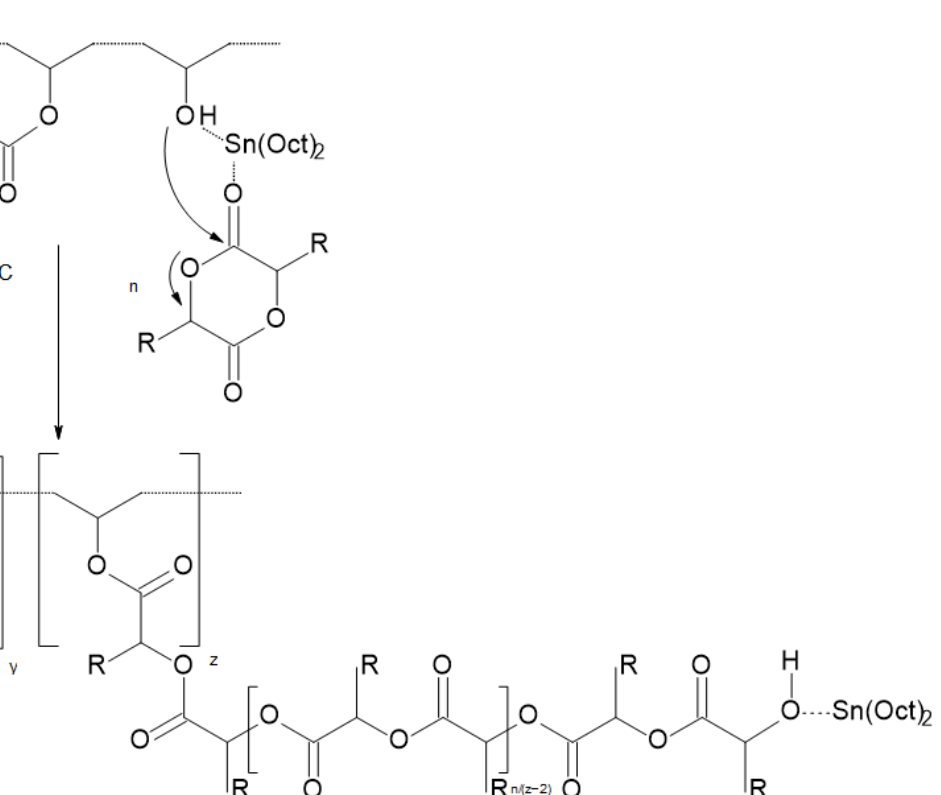
Figure 22. Synthesis of graft polymer PLA (PGA) on PVA by “grafting from” method [82].